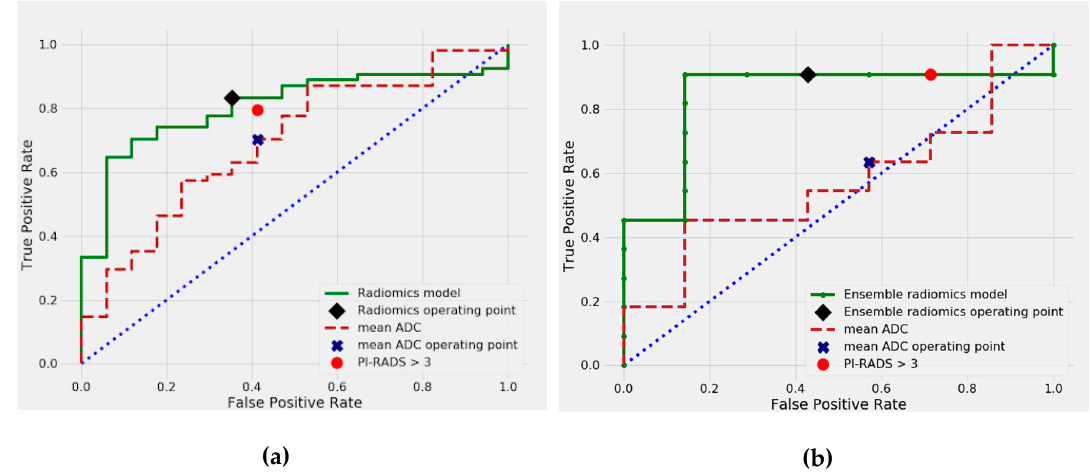
Figure 2. ROC curves for csPCa vs. cisPCa classification, in ( a ) cross-validation, ( b ) independent test set. csPCa = clinically significant prostate cancer; cisPCa = clinically insignificant prostate cancer.